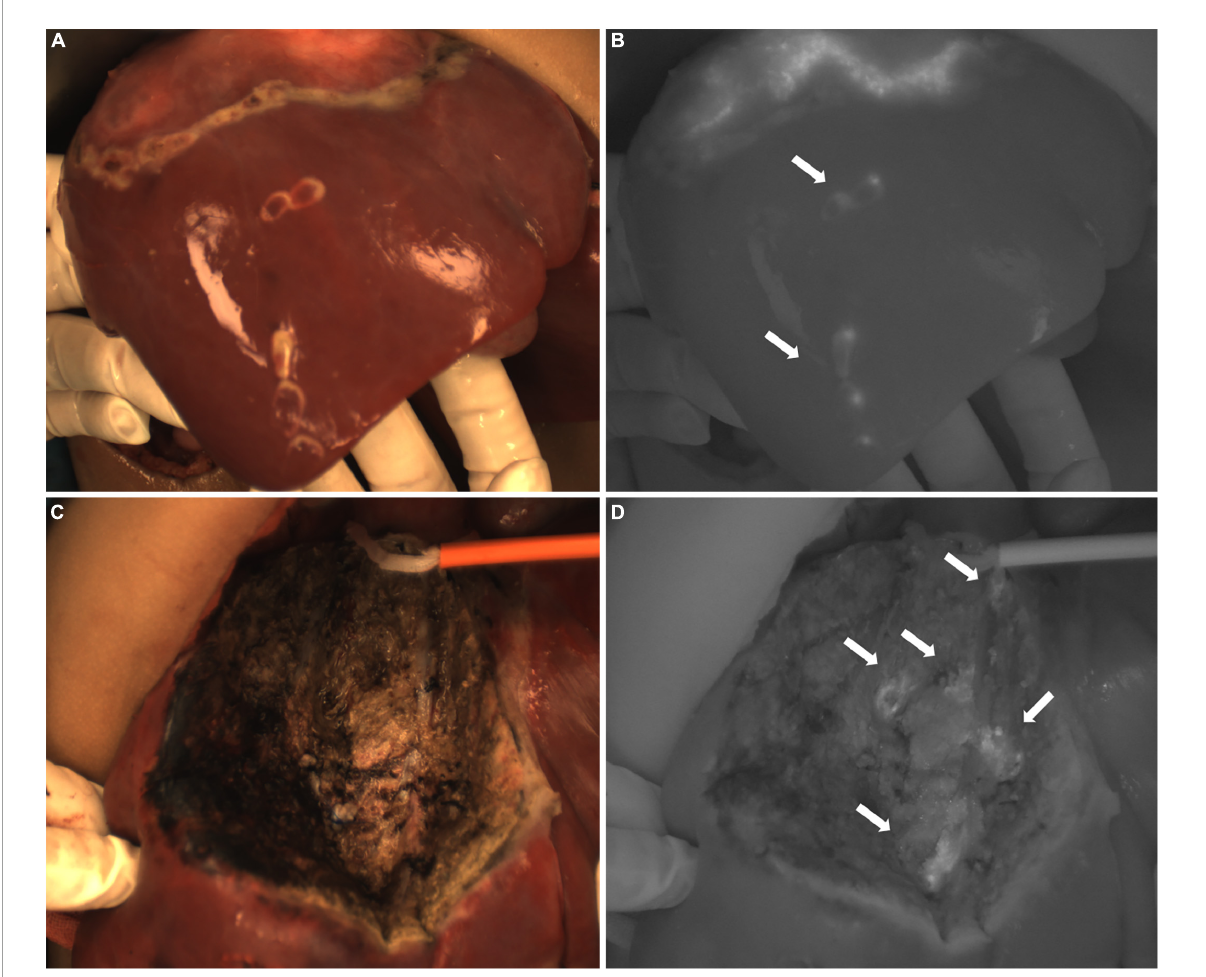
FIGURE9 Case 10. (A,B) Intraoperative white light and fluorescence images of ICG (+) lesions in the right lobe of the liver, with white arrows pointing to 5 lesions. (C,D) The intraoperative white light and fluorescence images of the resection stump of the residual liver tissue, with white arrows pointing to five ICG (+) regions,